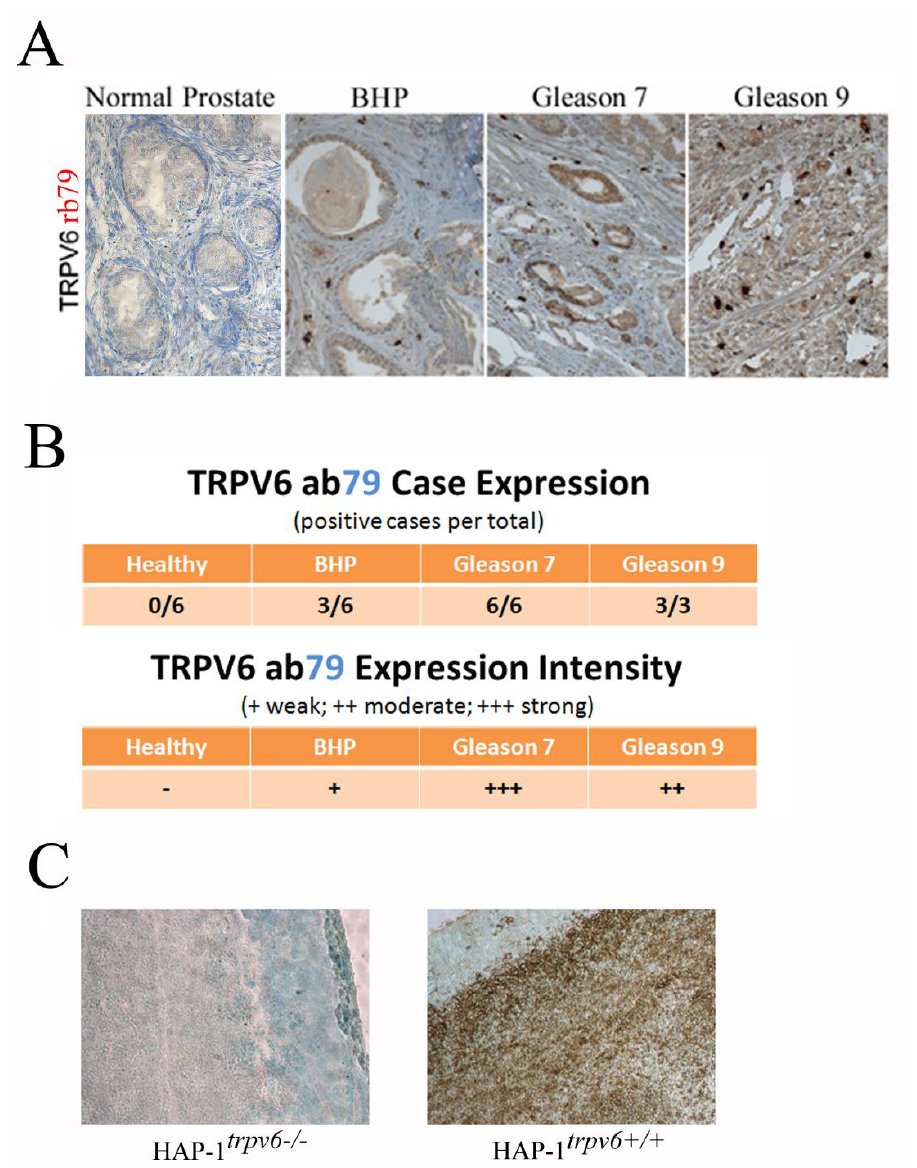
Figure 6. TRPV6 detection in human clinical samples using rb79. ( A ), IHC using rb79 of the human clinical samples from prostate resection specimens in the case of normal prostate (bladder cancer resection specimen), benign hyperplasia of the prostate (BHP), and adenocarcinoma with Gleason scores 7 and 9 (magnification × 200). ( B ), statistical analysis of the number of cases expressed and the intensity of those expressions in clinical samples using RB79 in 21 patient cohorts. ( C ), IHC of tumors slices derived from tumors grafted into nude mice and bearing either HAP-1 trpv6 − / − (left) or HAP-1 trpv6+/+ (right) cell lines (magnification ×200).